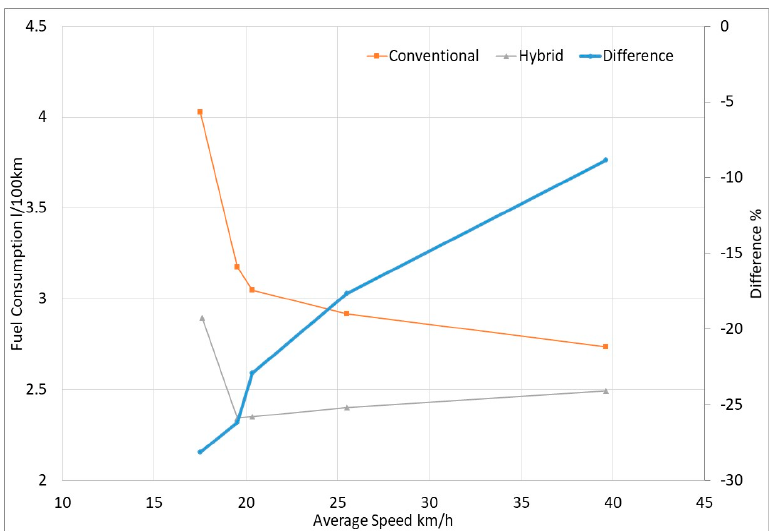
Figure 12. Fuel consumption of the conventional microcar and the hybrid version for different driving cycles with different average speeds.